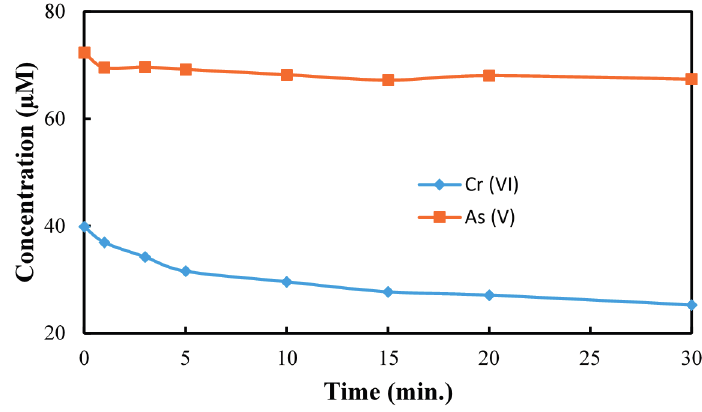
Figure 4. The reduction of As(V) in presence of Cr(VI). [Cr(VI ) ] 0 = 40 µM, [As(V)] 0 = 80 µM, pH = 3, [TiO 2 ] = 0.10 g/L, 350